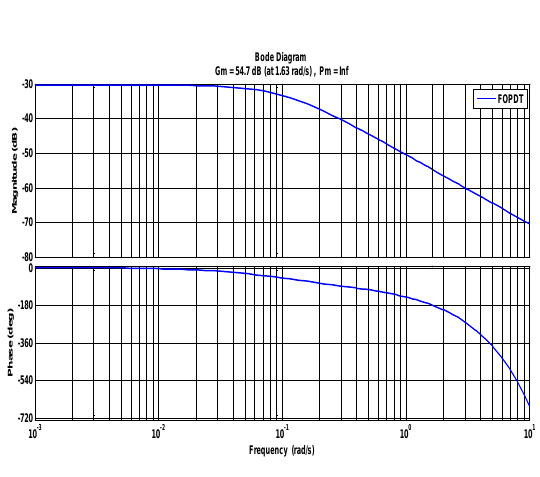
Figure 4. Bode plot of G Pade’s (s)